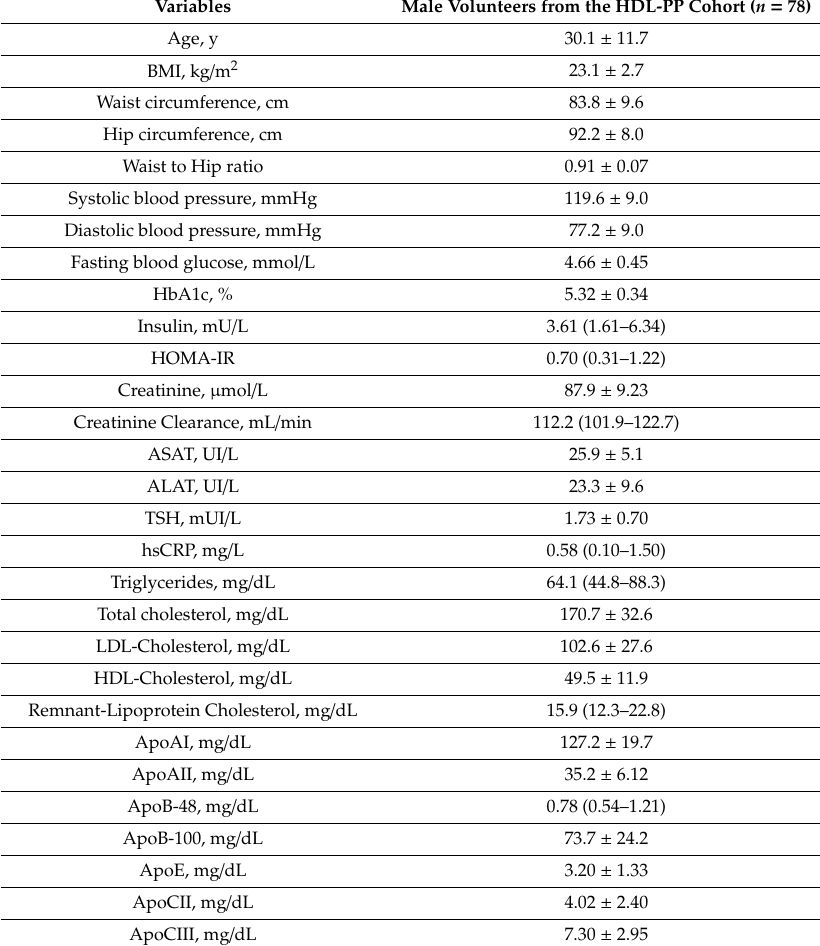
Table 1. Clinical and biological characteristics of the study